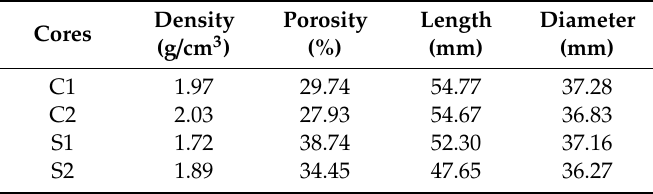
Table 1. The physcial parameters of natural recovered